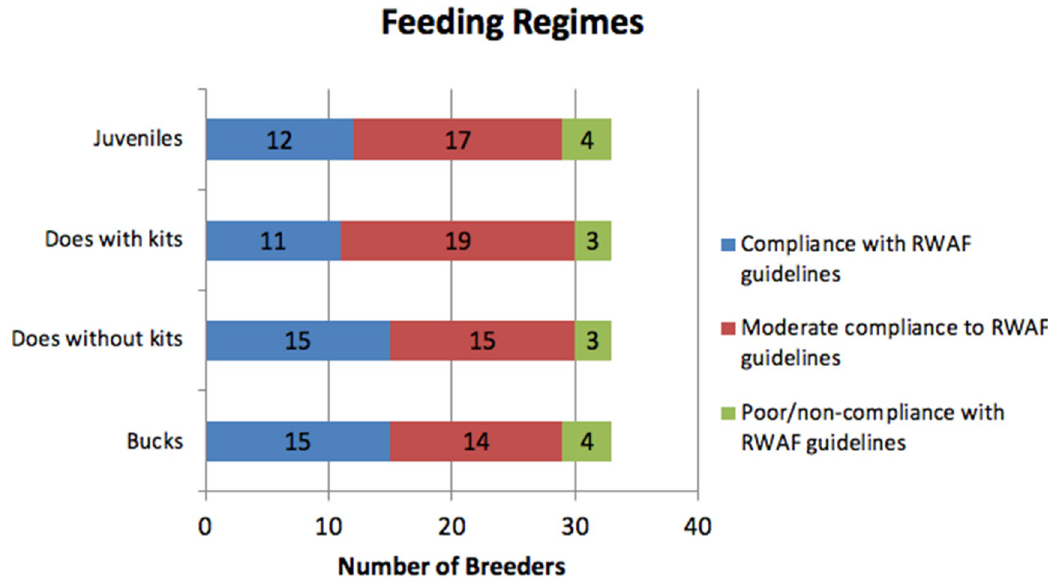
Figure 3 . Compliance of feeding regimes with guidelines for diet provided by the Rabbit Welfare Association and Fund (RWAF) [26].